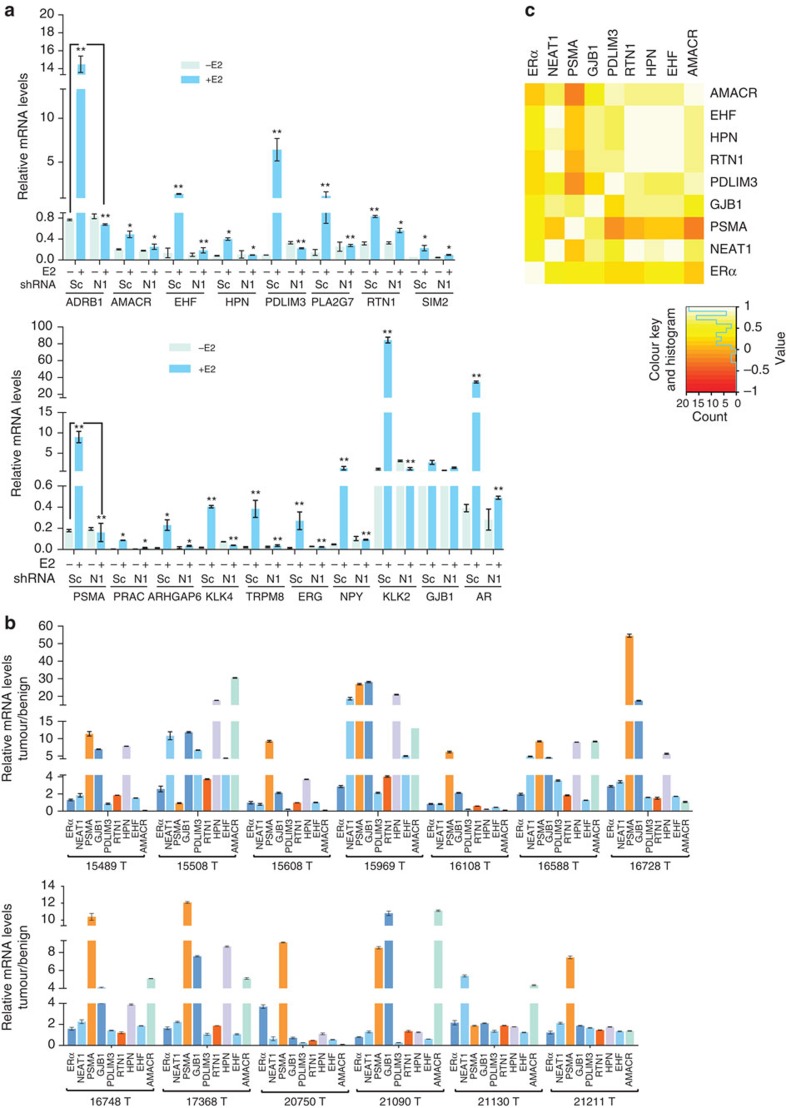
NEAT1 ERα signature is upregulated in prostate cancer.(a) Relative mRNA levels of genes nominated from analysis in Fig. 3b,e, analysed using qRT–PCR in parental VCaP cells transfected with scrambled (Sc) and NEAT1 shRNA (N1), respectively, with and without E2 (10 nM) treatment. Results are expressed as the mean±s.d. calculated from three independent experiments. Student’s t-test was performed for comparisons (relative mRNA levels of target gene expression) between −E2 and +E2 conditions for scrambled shRNA and NEAT1 shRNA transfections. A representative example is shown for ADRB1 and PSMA target expression. *P<0.05 and **P<0.01 were considered statistically significant. (b) Validation of expression of the top target NEAT1 ERα signature genes in a small matched patient cohort of 13 benign and 13 PCa, n=26. Results are expressed as the relative mRNA levels tumor/benign from two independent experiments. Error bars represent the range of data. (c) Heatmap shows the Spearman’s correlation results from b.